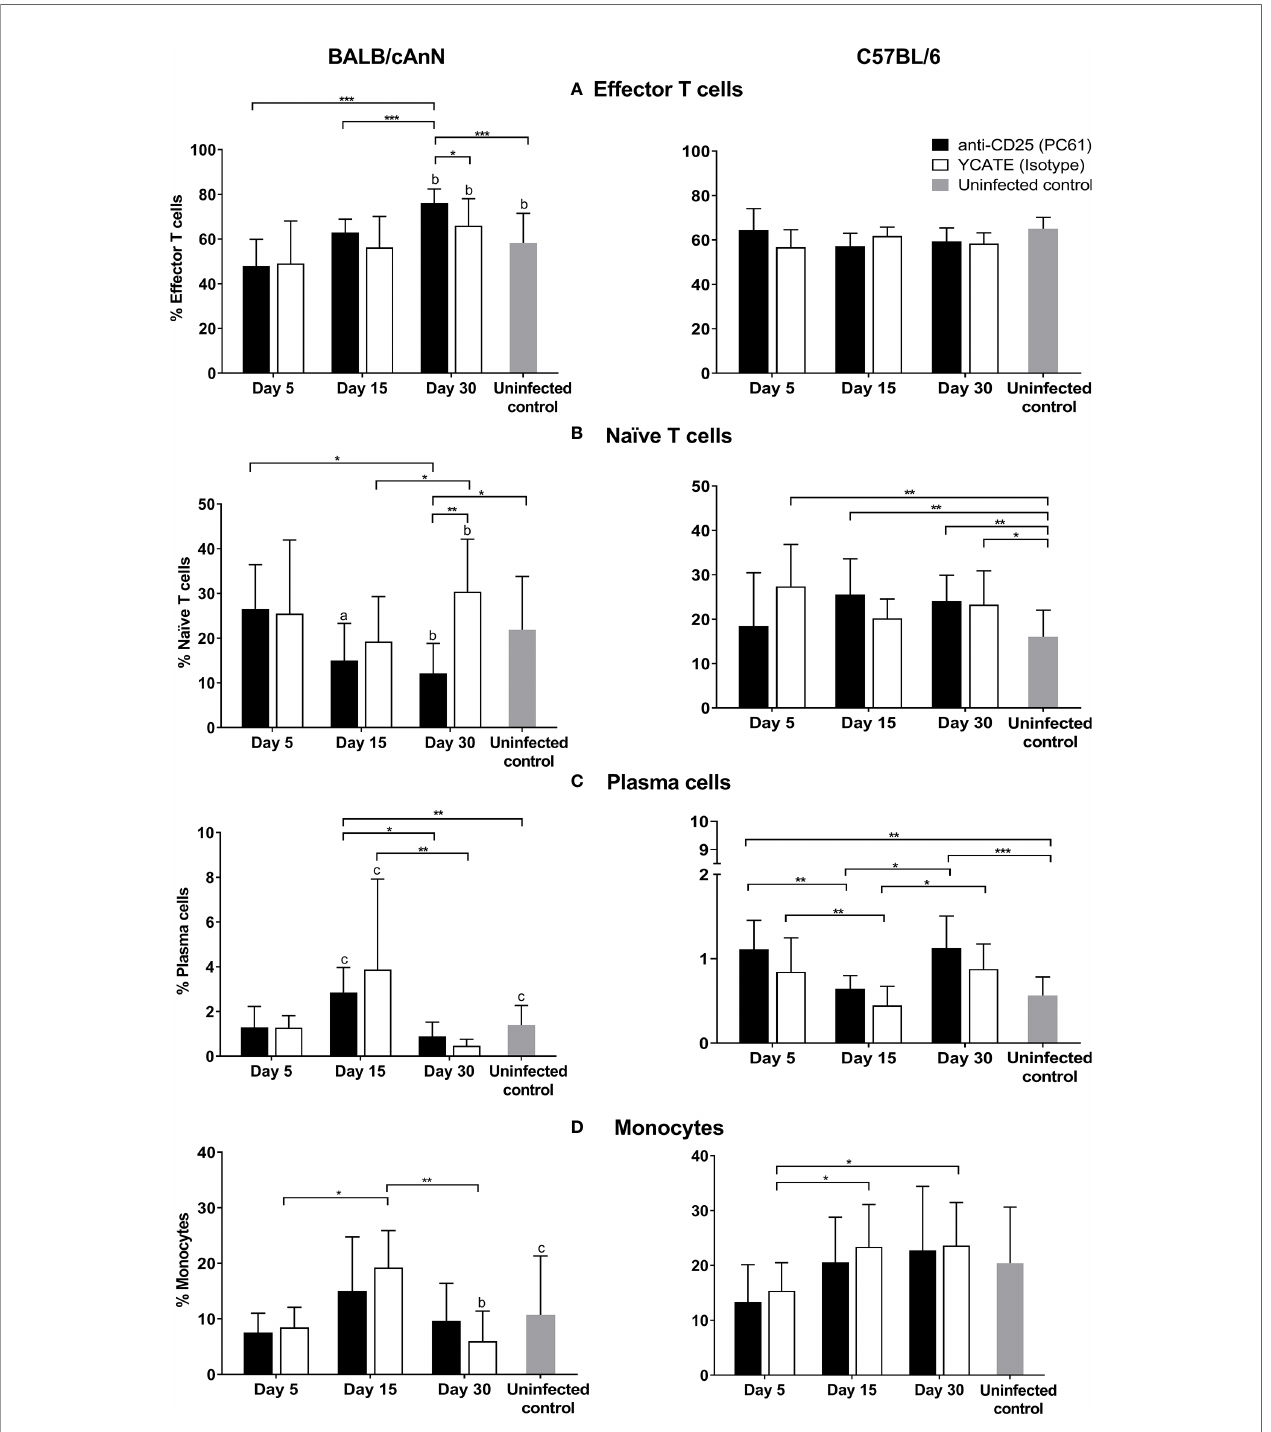
FIGURE 4 | Effect of regulatory T cell depletion on the kinetics of various cell populations in peritoneum after Taenia crassiceps infection in Treg-depleted and non- depleted mice. (A) Effector T cells, (B) naïve T cells, (C) plasma cells, and (D) monocytes. Flow cytometry results are reported as a mean and standard deviation (bar graph). Six infected mice for each time (days 5, 15, and 30) and each condition (isotype or depleted) were included, as well as six non-infected animals of each strain. Signi fi cant differences in cell percentages as determined by the U Mann-Whitney test are shown as * P < 0.05, ** P < 0.01, *** P < 0.005. Signi fi cant differences between strains were determined by the U Mann-Whitney test. Superscript letters indicate: a P < 0.05, b ** P < 0.01, and c ** P <